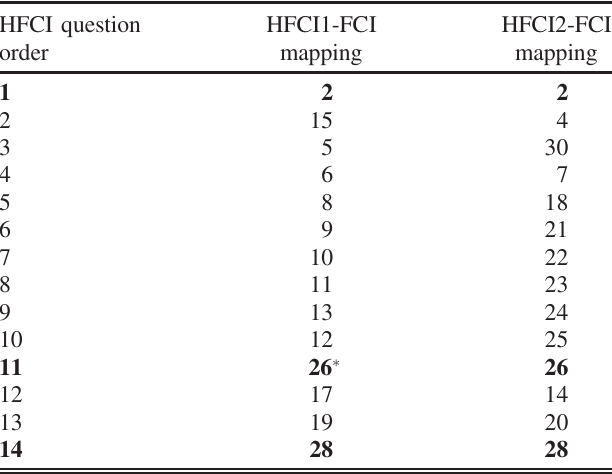
TABLE I. FCI to HFCI mapping. The question order for each HFCI is shown below, with mapping to FCI-95 questions. Questions in bold font appear on both versions of the HFCI and in the same question position. Question 11 in HFCI1, with an asterisk (*), was slightly edited to include the narrative of the referring question (Q25) to make it suitable as a standalone question. To obtain the actual test, see the Table footnote a .